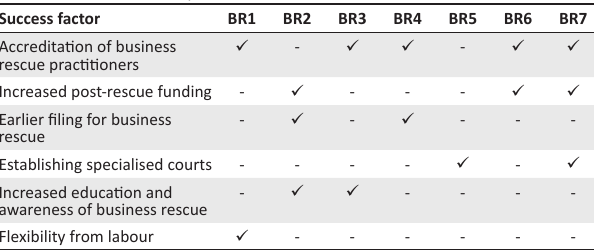
TABLE 2: Factors that may result in an increased business rescue success.